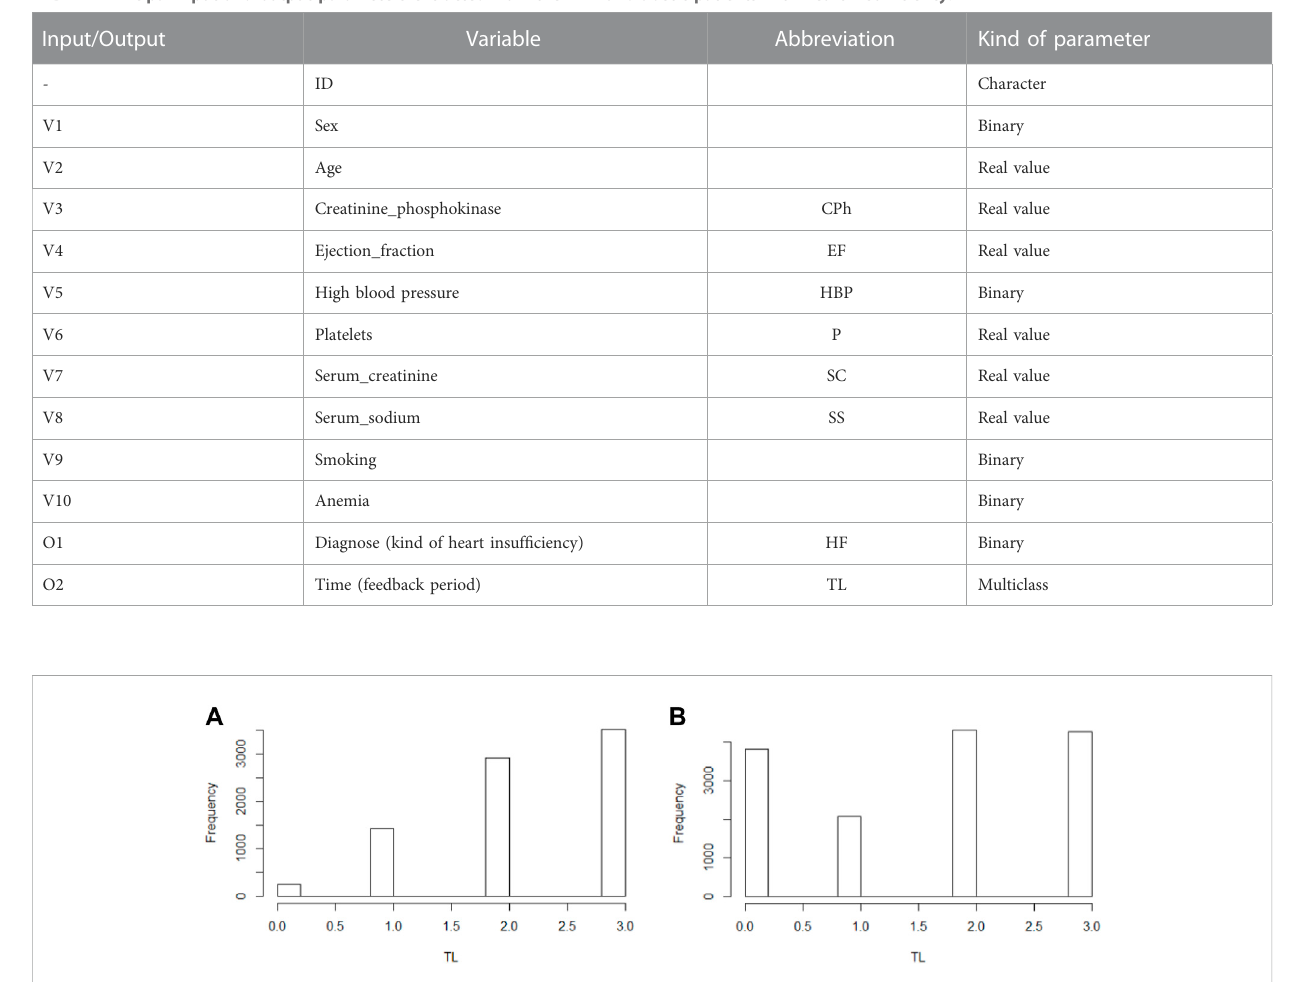
FIGURE 1 Distribution therapy length in the population in the original population (A) and the SMOTE balanced population (B)